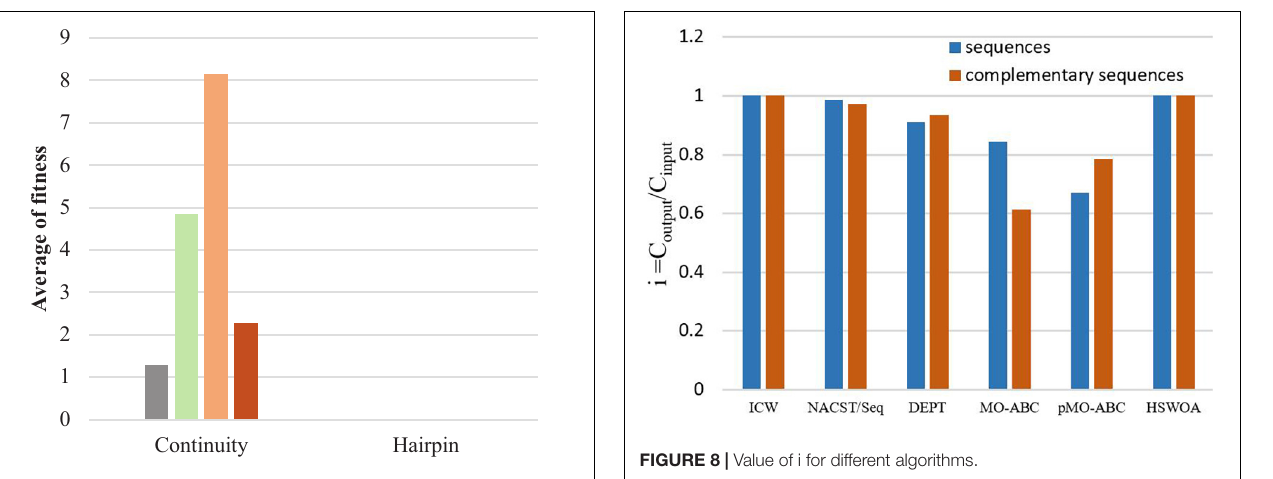
FIGURE 8 | Value of i for different algorithms.